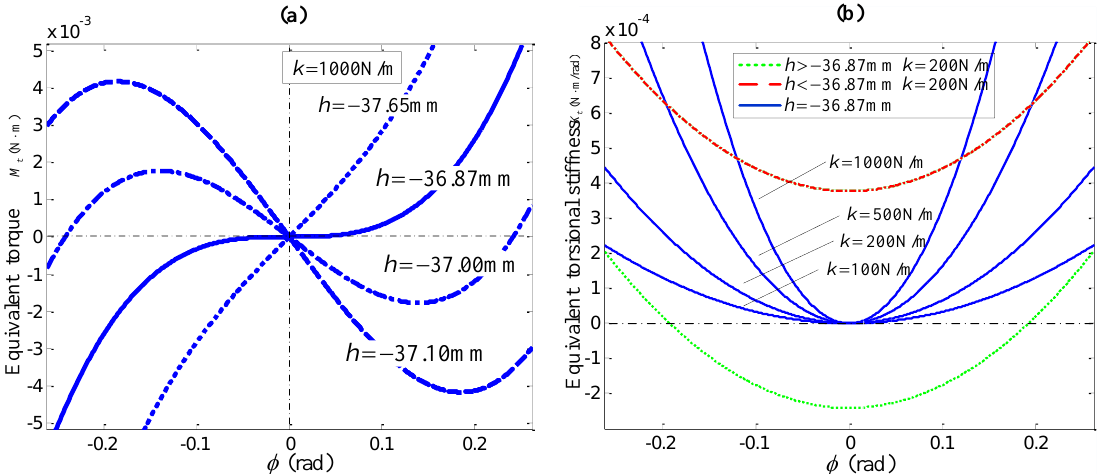
Figure 3. ( a ) The equivalent relationship between the torque and angle at k = 1000N/m; ( b ) Distribution of the equivalent torsional stiffness.